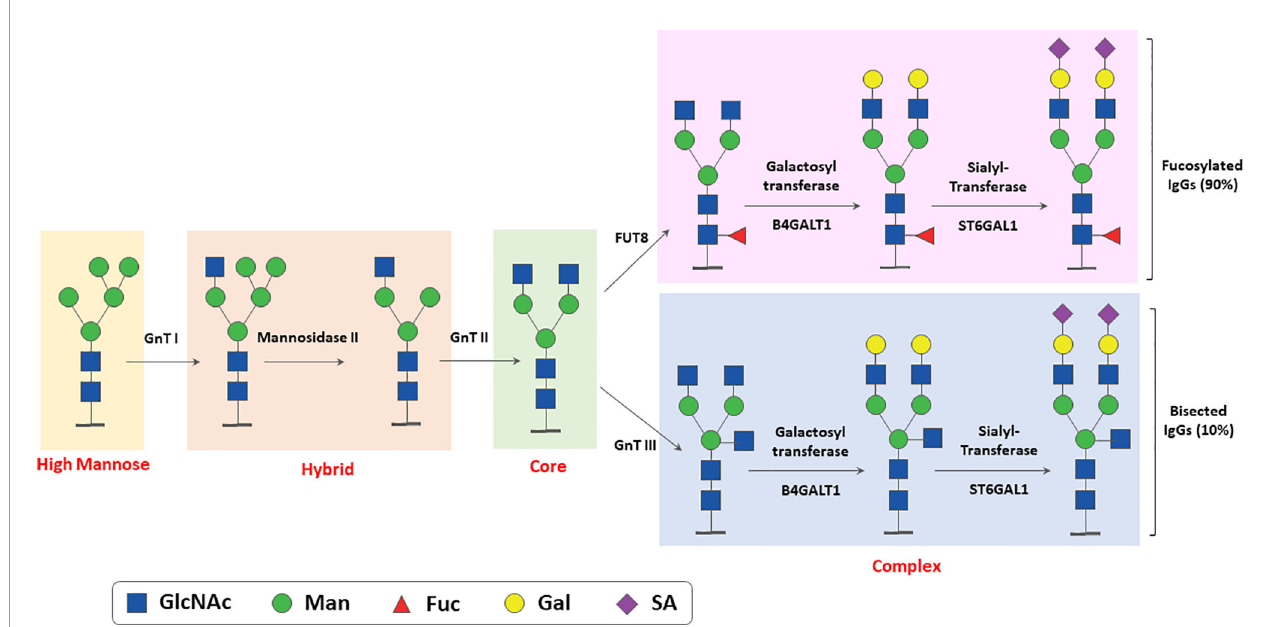
FIGURE 2 | Simpli fi ed scheme of enzymatic reactions involved in N-linked glycosylation of IgG. The major glycosylation steps and enzymes involved in N- linked glycosylation of IgGs taking place in ER and Golgi are shown. GnT, N-Acetyl glucosamine transferase; FUT, Fucosyl transferase; Man, Mannose; Gal, Galactose; GlcNAcm N-acetylglucosamine; SA, sialic acid (N-Acetylneuraminic